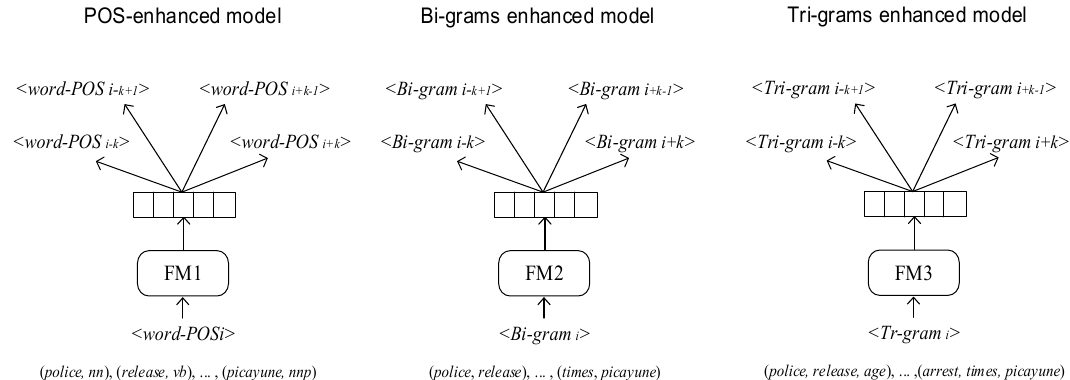
Figure 1. Enhanced feature embedding models with skip-gram.